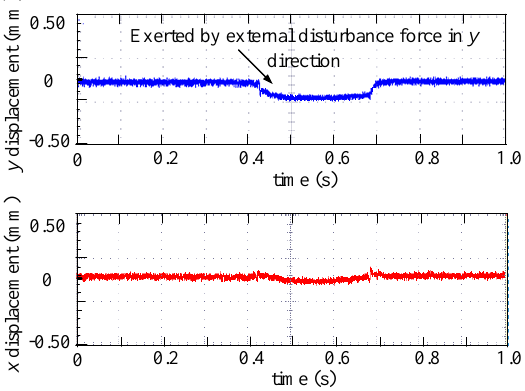
Figure 9. Waveforms of disturbance test in radial direction.